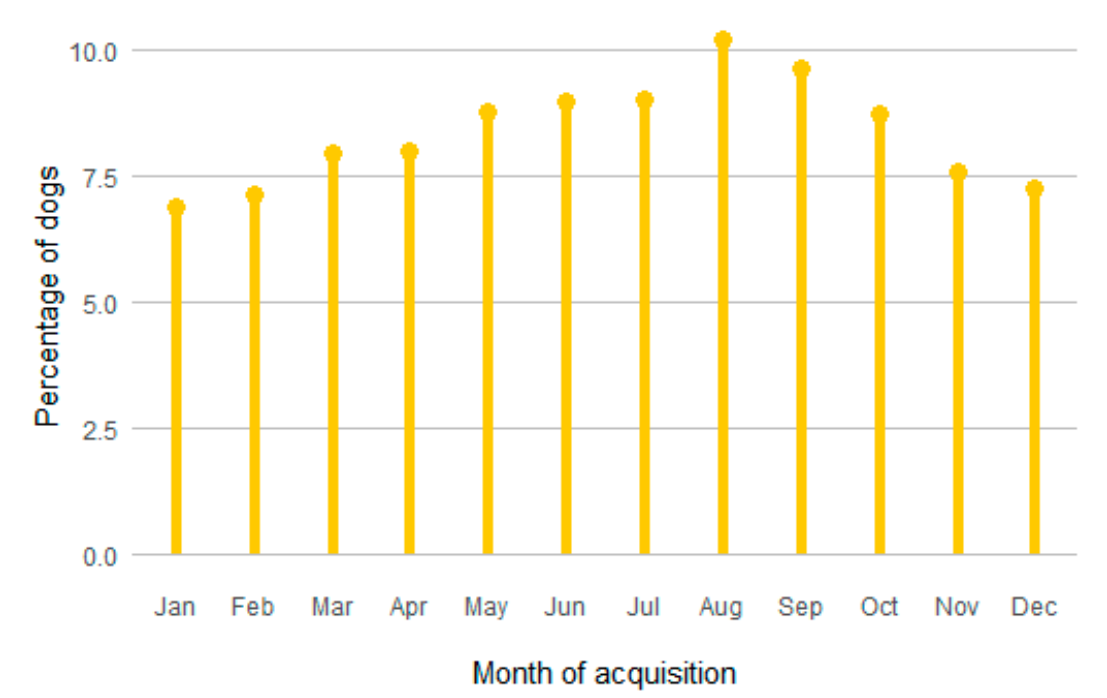
Figure 4. Chart showing the percentage of dogs acquired as broken down by month of acquisition .